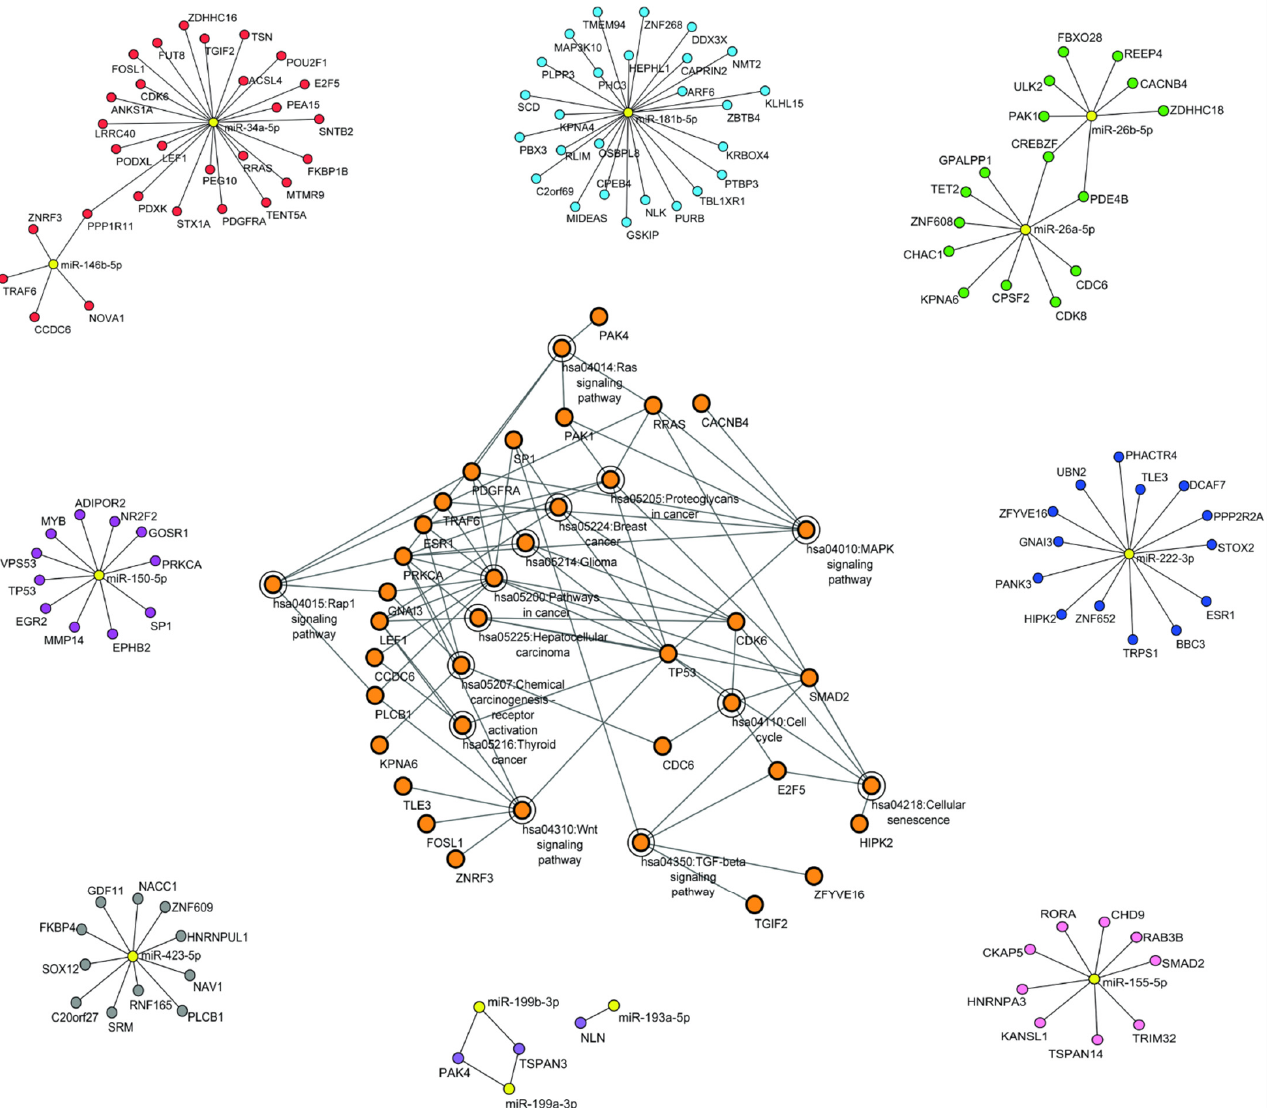
Figure 2. Cytoscape analysis network. A miRNA-gene interaction network was generated from a manual procedure of the intersection of individual networks made from target prediction data generated with miRWalk. It was possible to build all networks of all miRNAs: miR-34a-5p, miR-146b-5p, miR-181b-5p, miR-26a-5p, miR-26b-5p, miR-222-3p, miR-155-5p, miR-193a-5p, miR-199a-3p, miR-199b-3p, miR-423-5p, miR-150-5p. The target genes of these 12 miRNAs were enriched with KEGG and normalized to Log2 ( p -value). At the center, we propose a wider interaction network with the target genes of these miRNAs with their respective pathways, where many of these pathways are related to cancer.